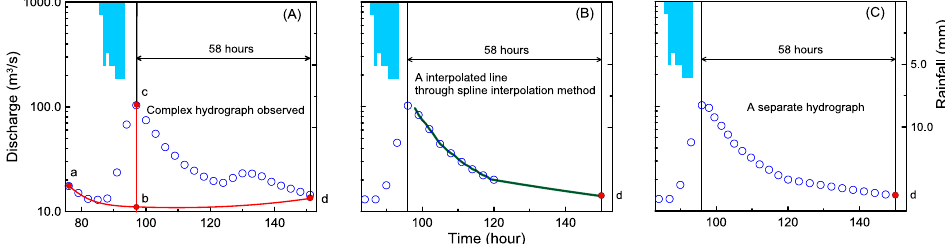
Figure 6. Procedure for hydrograph separation: ( A ) Schematic diagram of N-day method; ( B ) Schematic diagram of spline interpolation method; and, ( C ) Sample result of separated hydrograph.